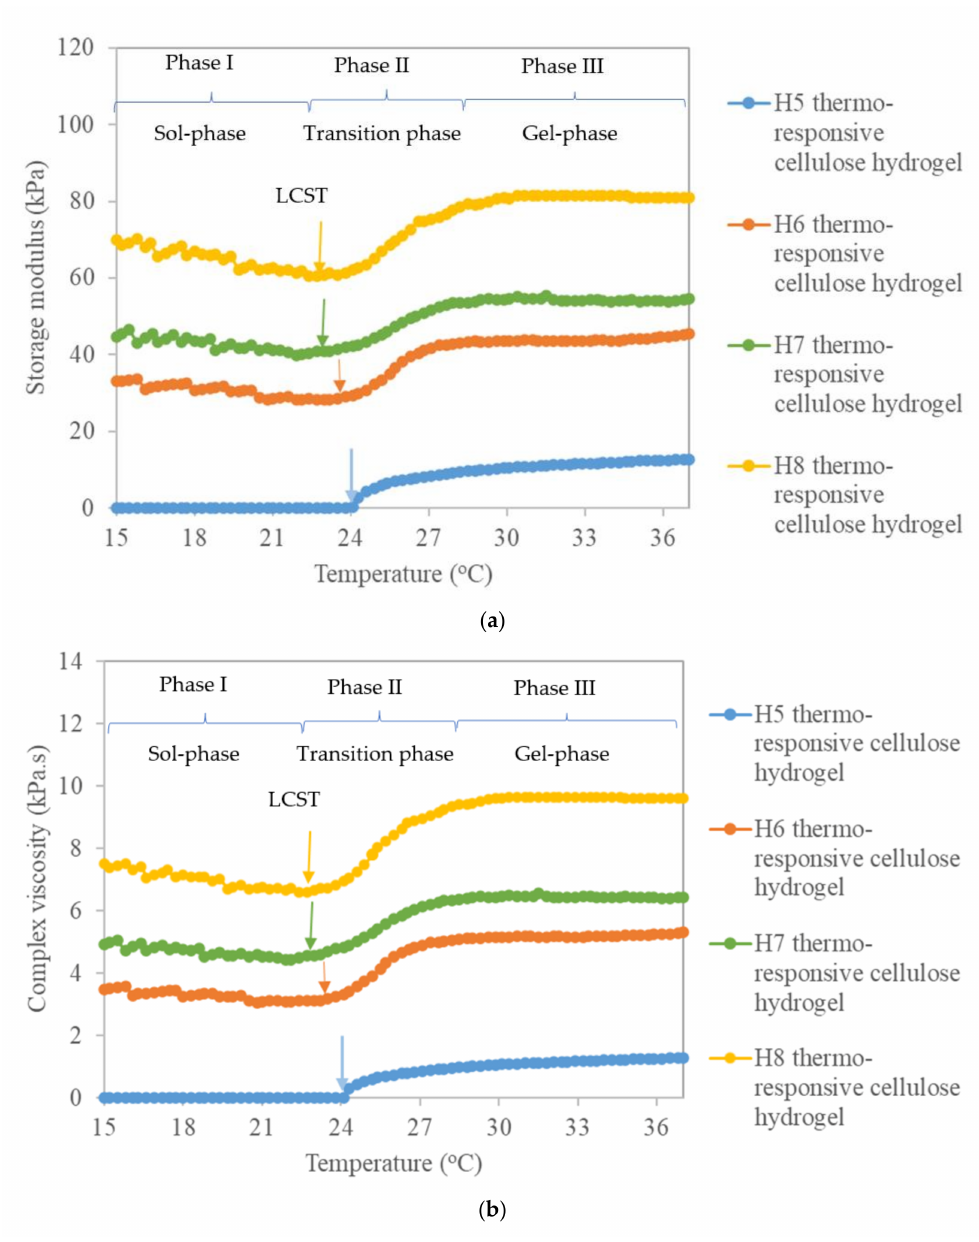
Figure 4. ( a ) Storage modulus (G (cid:48) ) and ( b ) complex viscosity ( η *) of thermo-responsive cellulose hydrogels as a function of